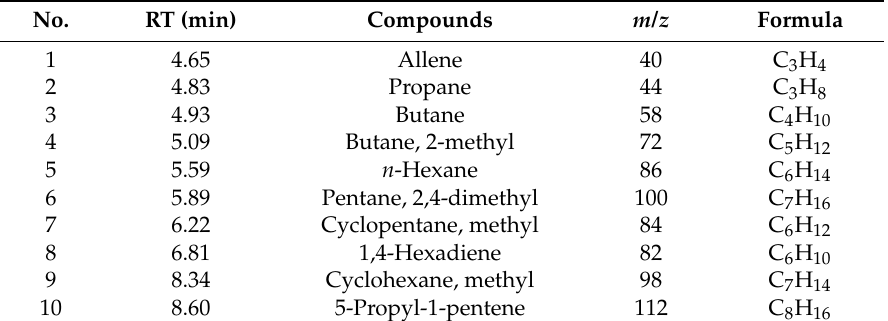
Table 1. Analytical results of the chemical constituents of the pyrolytic products of P(ND- co -D) precursor at 310 ◦ C.